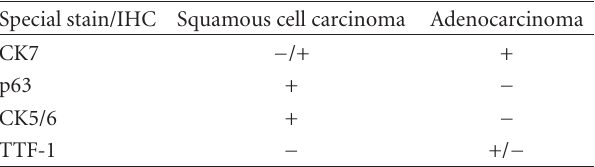
Table 1: Immunohistochemical profiles of squamous cell carci- noma and pulmonary